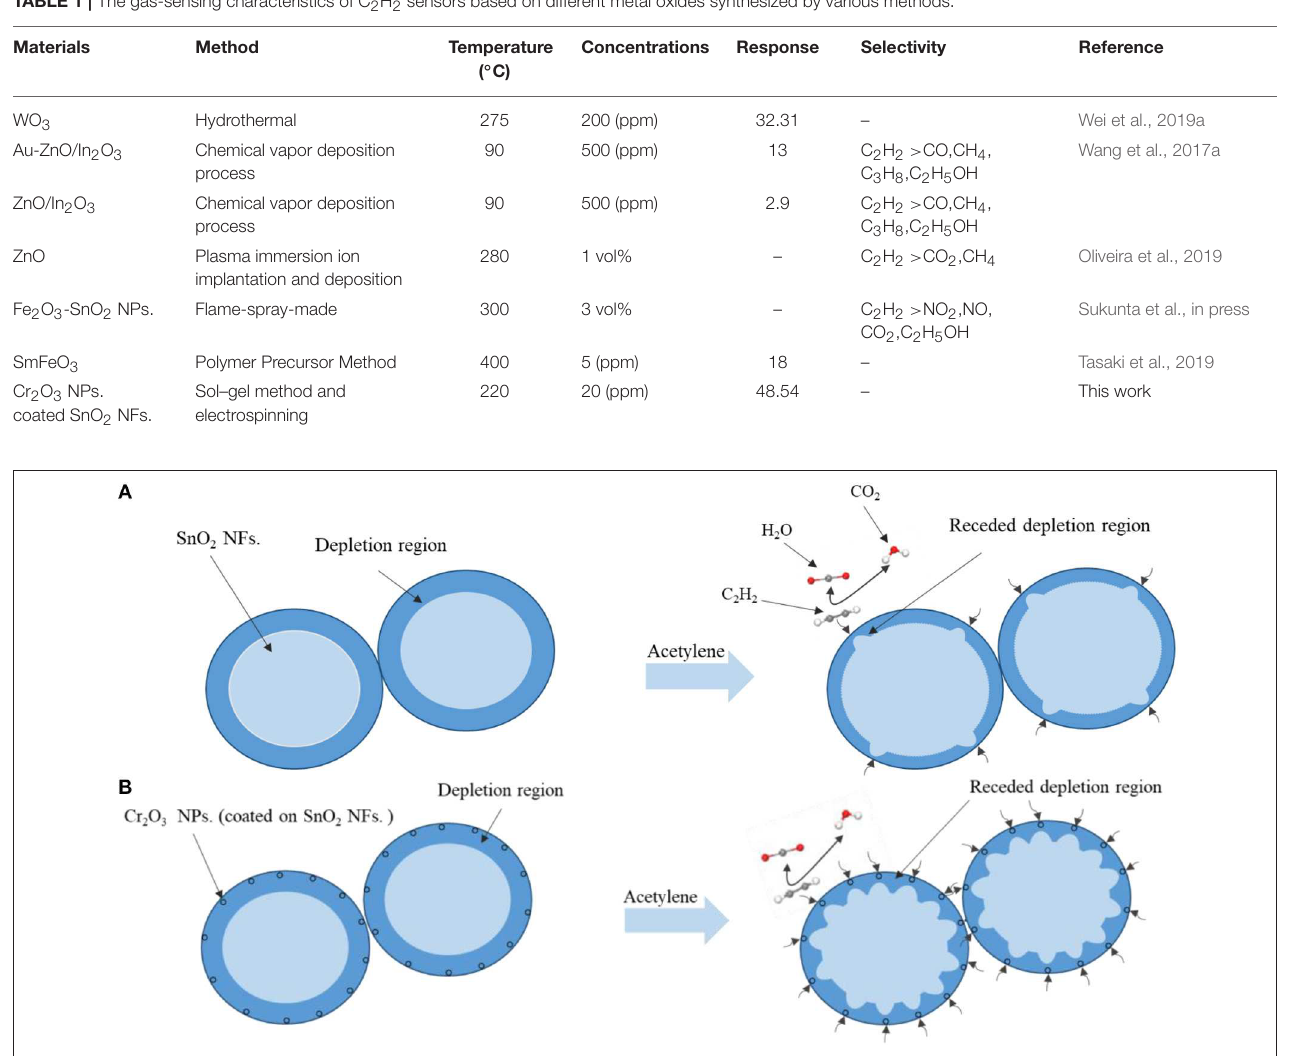
FIGURE 8 | The mechanism diagram of C 2 H 2 sensing process of (A) pure SnO 2 and (B) Cr 2 O 3 nanoparticle-coated SnO 2 nanofibers.